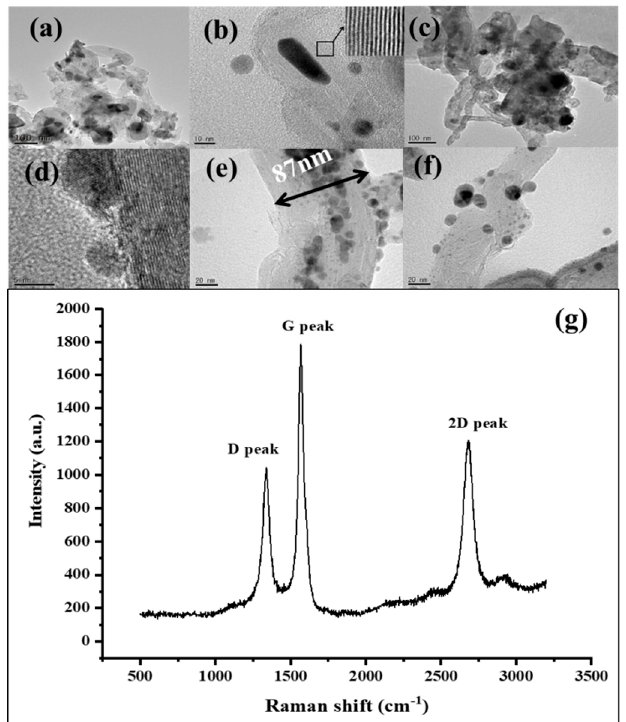
Figure 1. High-resolution transmission electron microscopy (HRTEM) images of ( a ) pristine MWNT, ( b ) magnification of single tube of pristine CNTs (inset: magnification of HRTEM image of outer shells.), ( c ) Ar + -irradiated MWNTs, ( d ) Ti nanoparticles on the normal outer wall of CNTs, ( e ) Ti nanoparticles on the larger-diameter defective CNTs, ( f ) Ti nanoparticles on the “junction” of defective CNTs, ( g ) Raman spectrum of pristine CNTs.